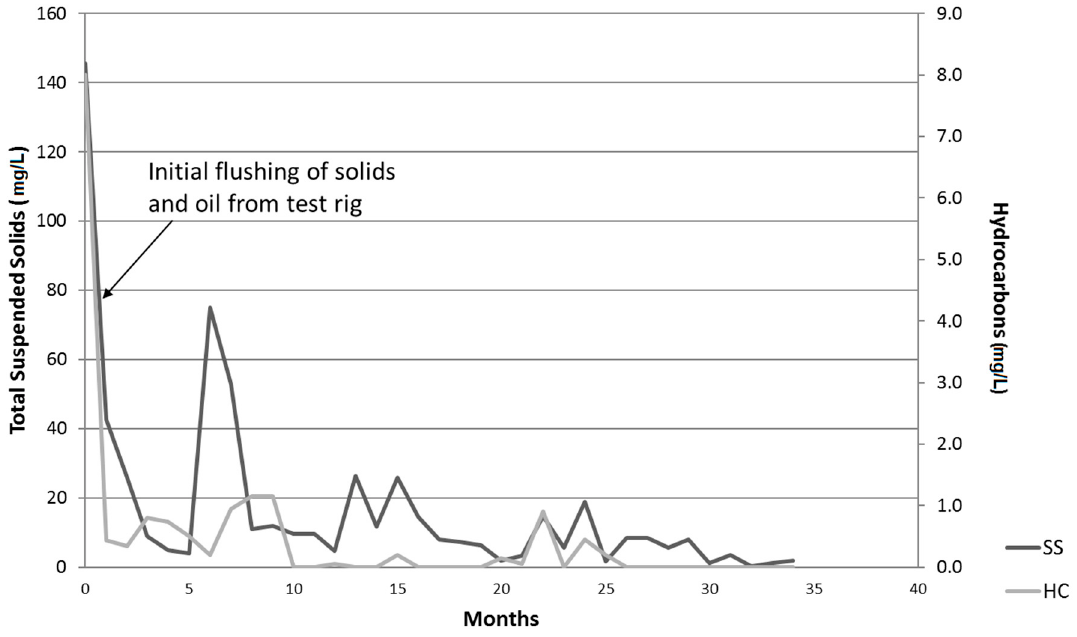
Figure 3. Hydrocarbons (HC) and suspended solids (SS) in the effluent (mg/L).